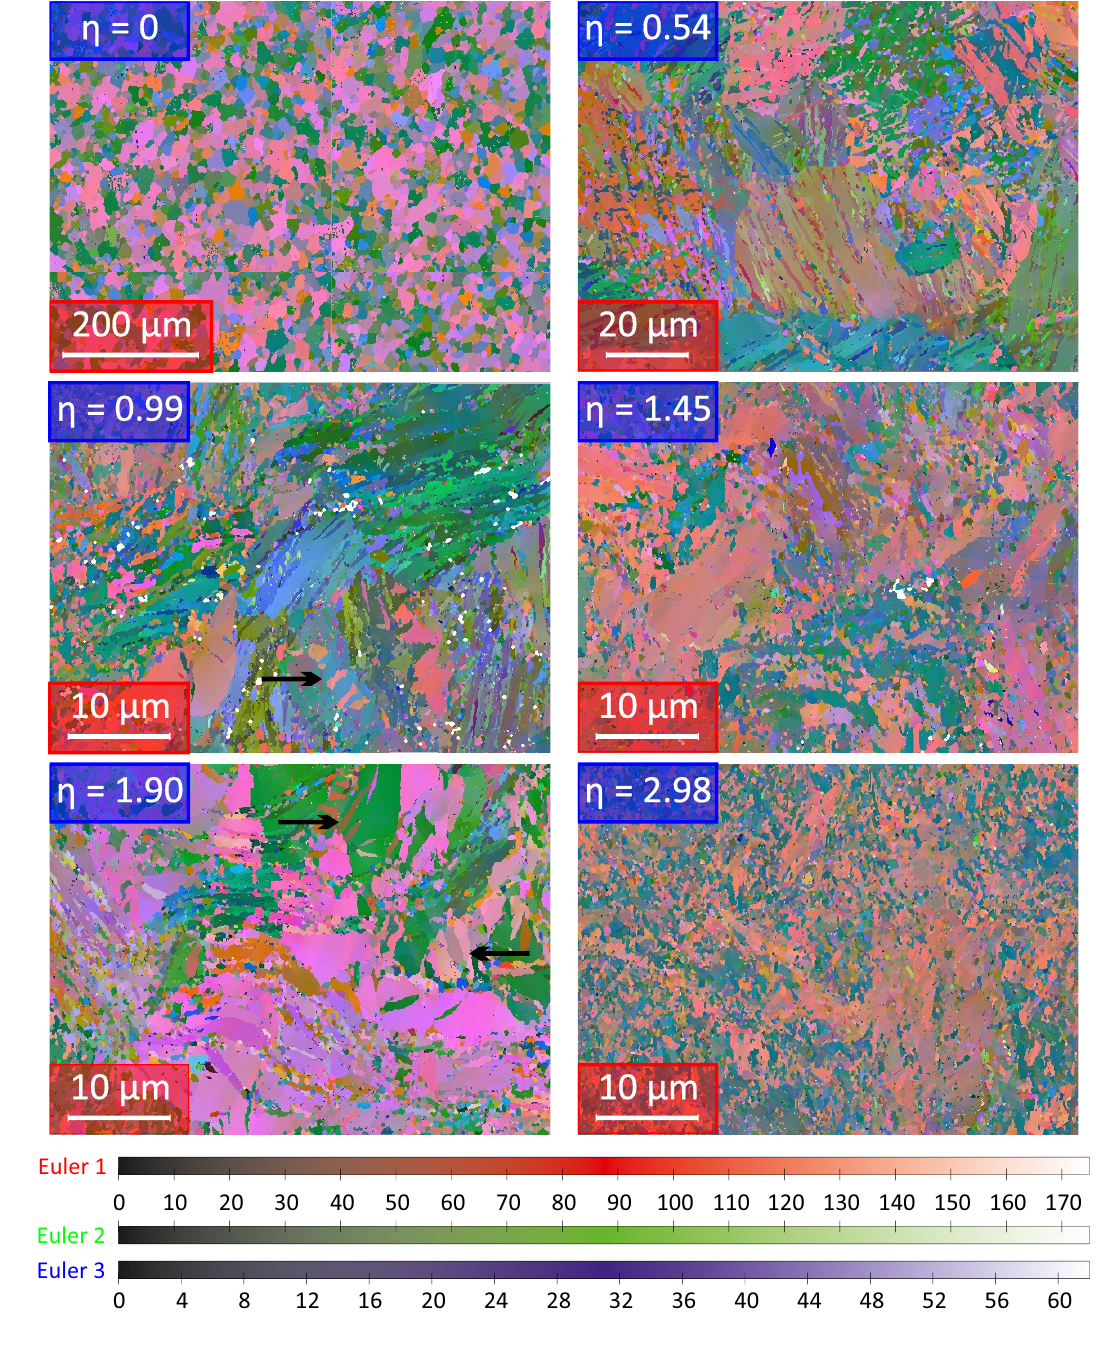
Figure 2. Orientation maps (SEM-EBSD) of AZ31 after cold rotary swaging to different true